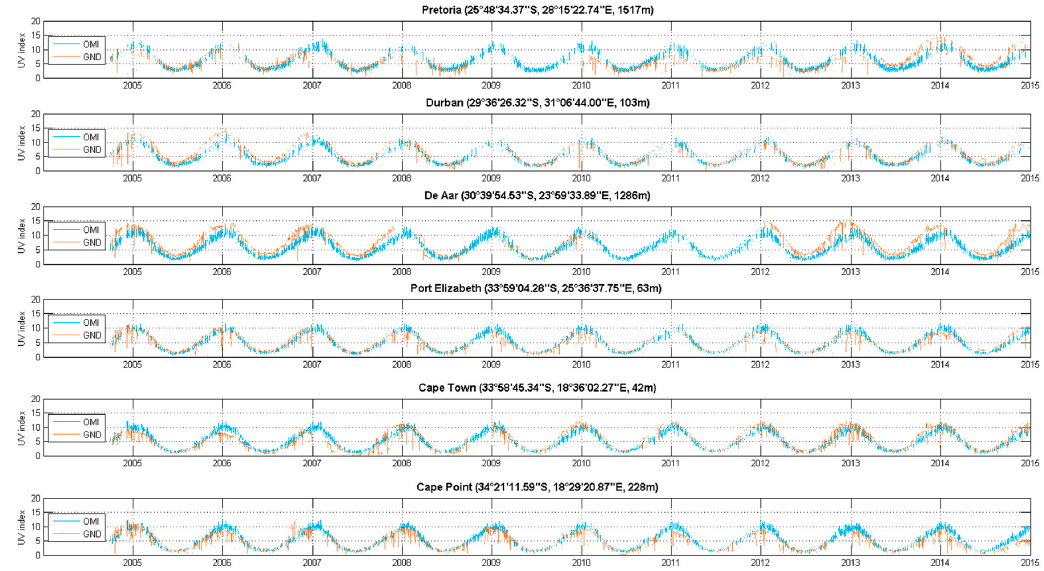
Figure 7. Time series comparing ground ‐ based versus satellite ‐ derived solar UV index data for 2005 to 2015 at satellite overpass time (the comparison was performed at the satellite overpass time and only clear sky days are selected with LER).